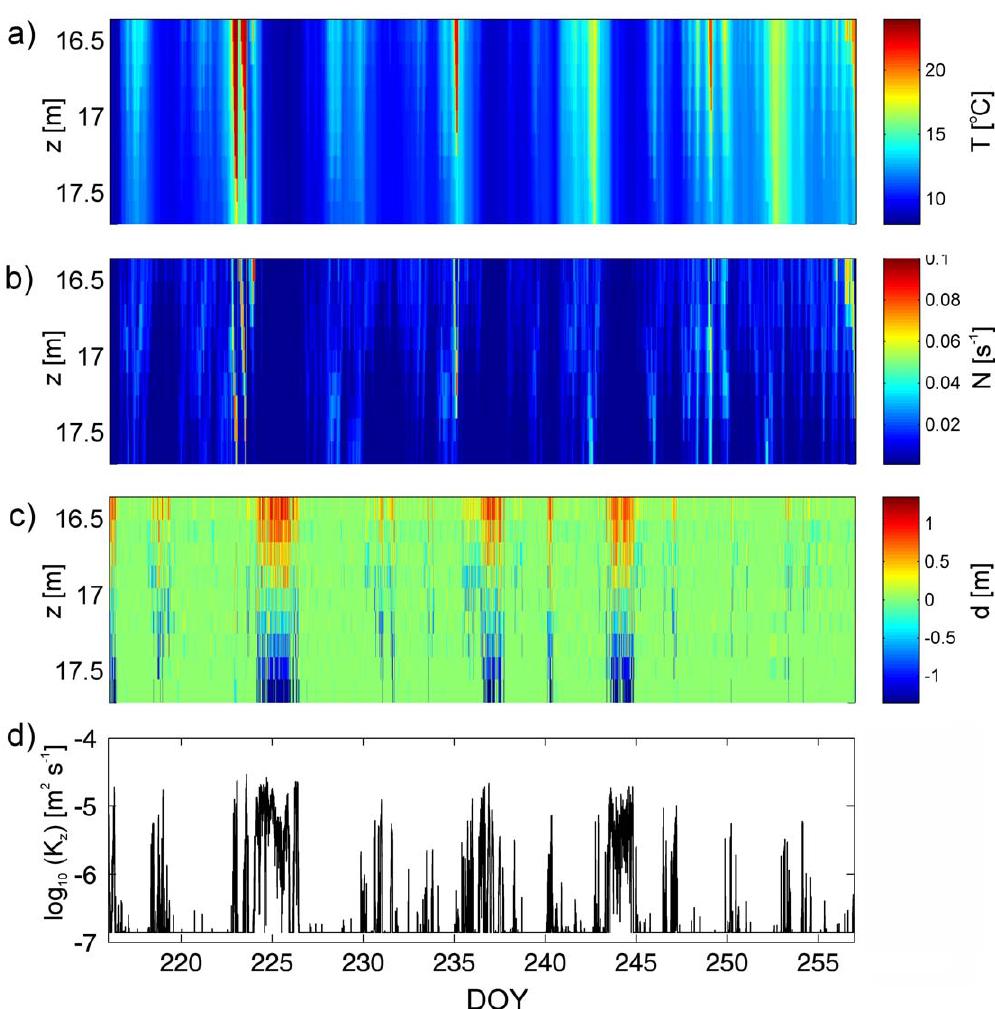
Figure 7. Near bed temperature time series and estimates of turbulent parameters at the benthic thermistor chain site T3. a) Observed temperature data. b) Buoyancy frequency N after reordering the temperature profiles to stable profiles at every time step. c) Estimated overturning displacements. d) Time series of the distribution of estimated eddy diffusivity averaged over the entire height of the benthic thermistor chain.